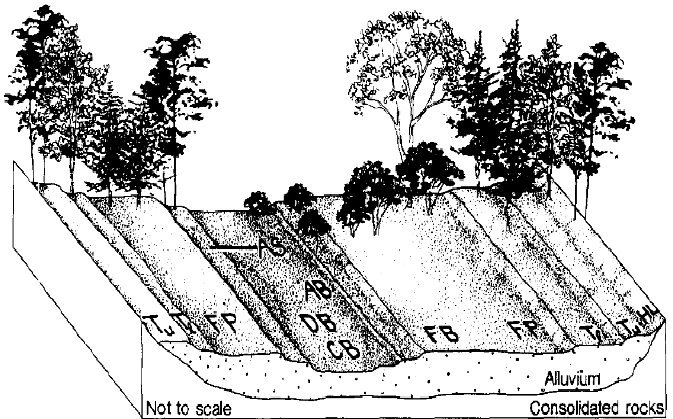
Figure 4. Fluvial geomorphic and vegetative characteristics (AB = channel-shelf bank, AS = channel shelf, CB = channel bed, DB = depositional bar, FB = bank below the floodplain, FP = floodplain, HL = hillslope, T l = lower terrace, and T u = upper terrace) (from [39]).